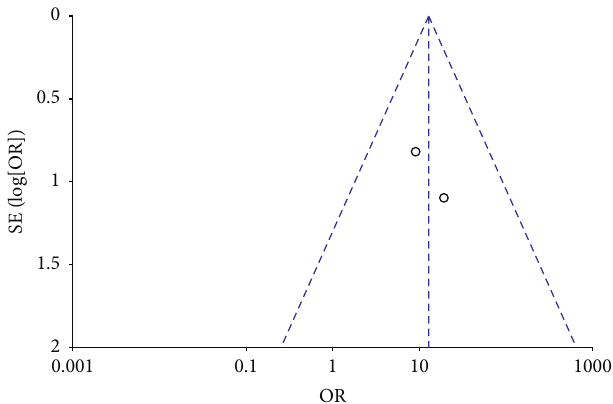
Figure 11: A funnel plot of preoperative BCVA showing no sig- nificant publication bias. BCVA � best-corrected visual acuity, SE � standard error, MD � mean difference.